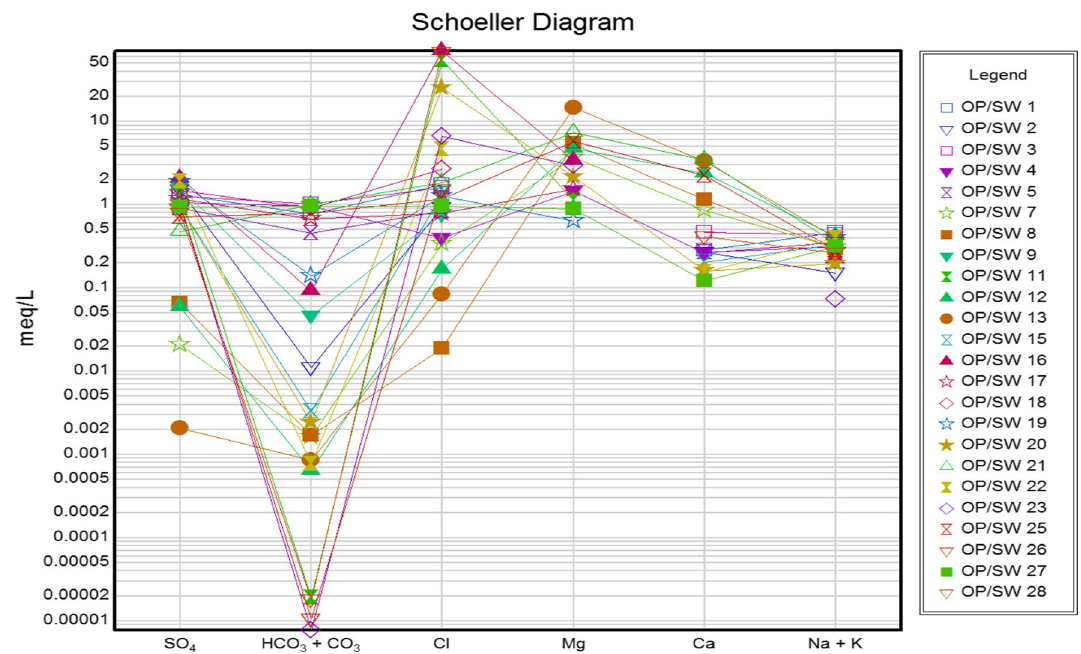
Fig. 9 Schoeller diagram of surface water resources in the Enyigba area (after Hem